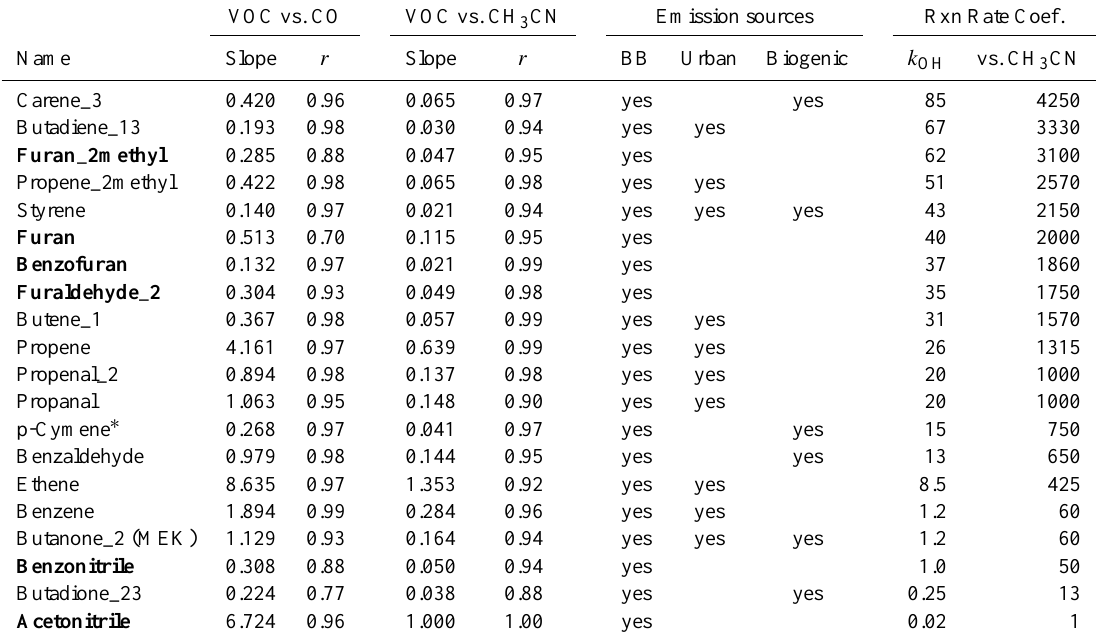
Table 3. Slopes and correlation coefficients ( r ) for VOC to carbon monoxide (CO) and VOC to acetonitrile (CH 3 CN) ratios observed in biomass burning (BB) plumes from the Fourmile Canyon Fire as identified in Fig. 6. VOC vs. CO VOC vs. CH 3 CN Emission sources Rxn Rate